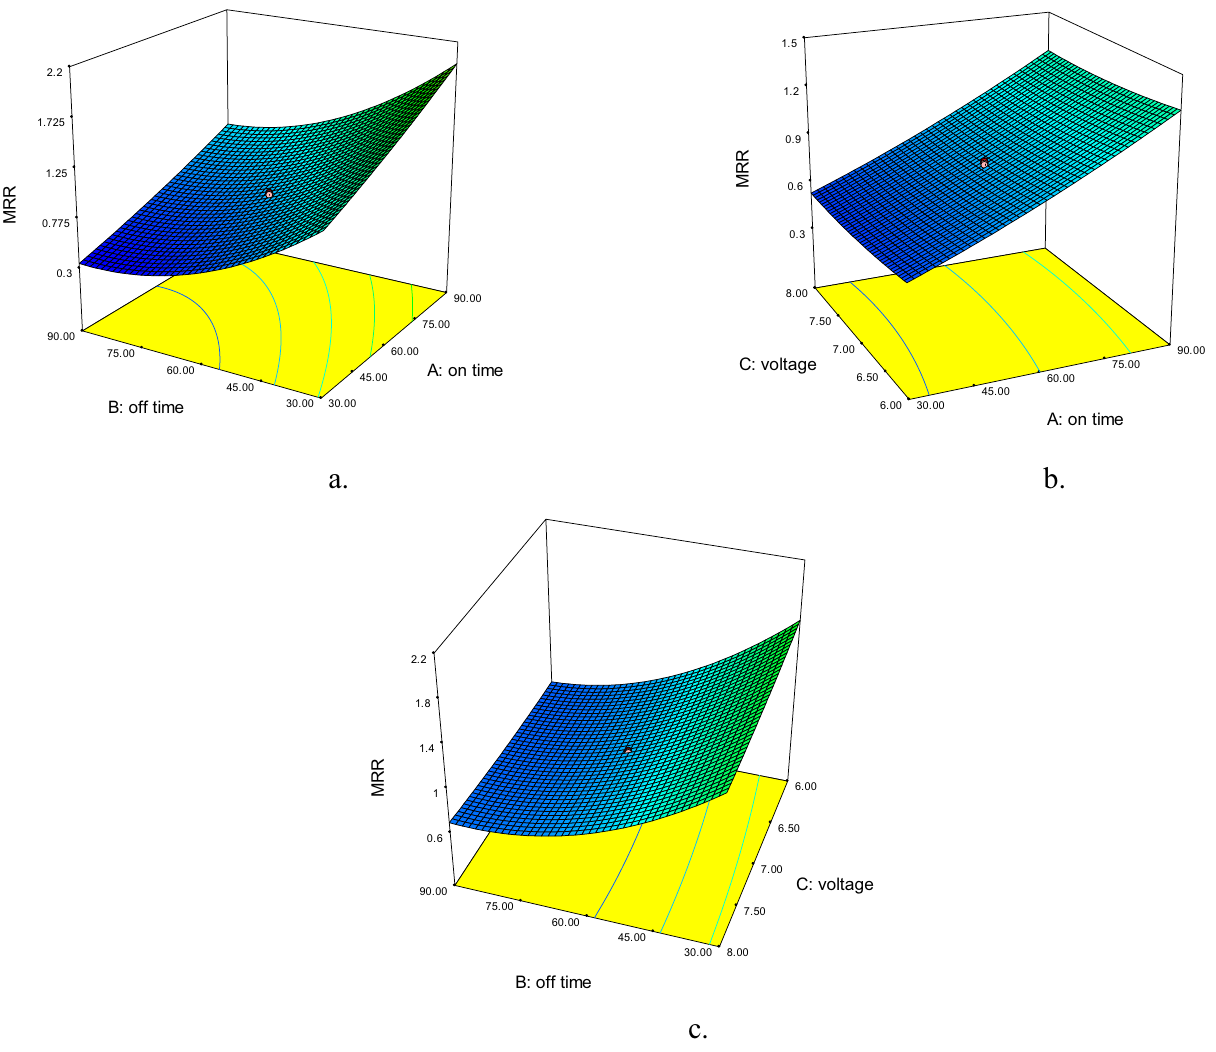
Figure 10: ( a ) Interaction e ff ect of P on and P o ff on MRR, ( b ) interaction in fl uence of voltage and P on on MRR and ( c ) interaction e ff ect of voltage and P o ff on